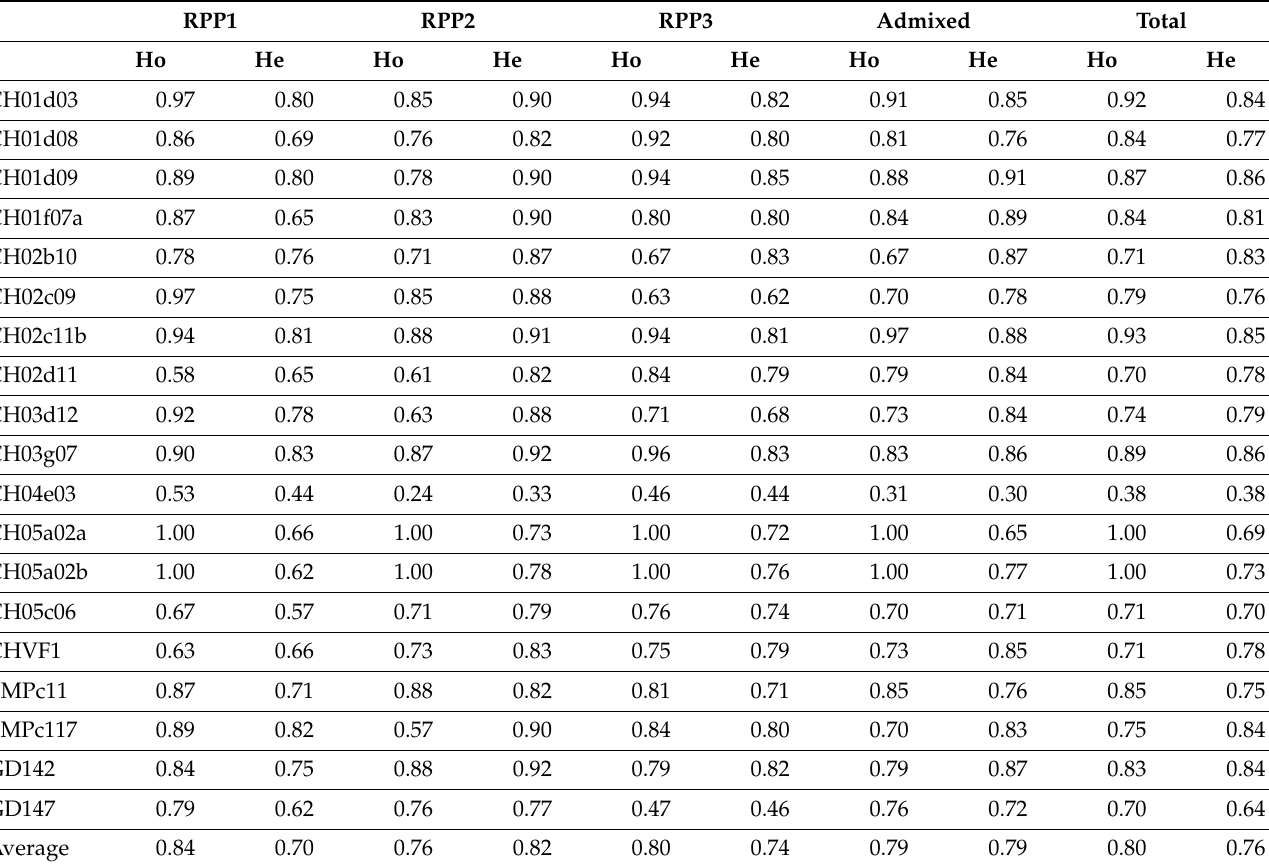
Table 6. Observed (Ho) and expected (He) heterozygosity in reconstructed panmictic populations (RPPs) of 192 diploid pear genotypes for K = 3 and 18